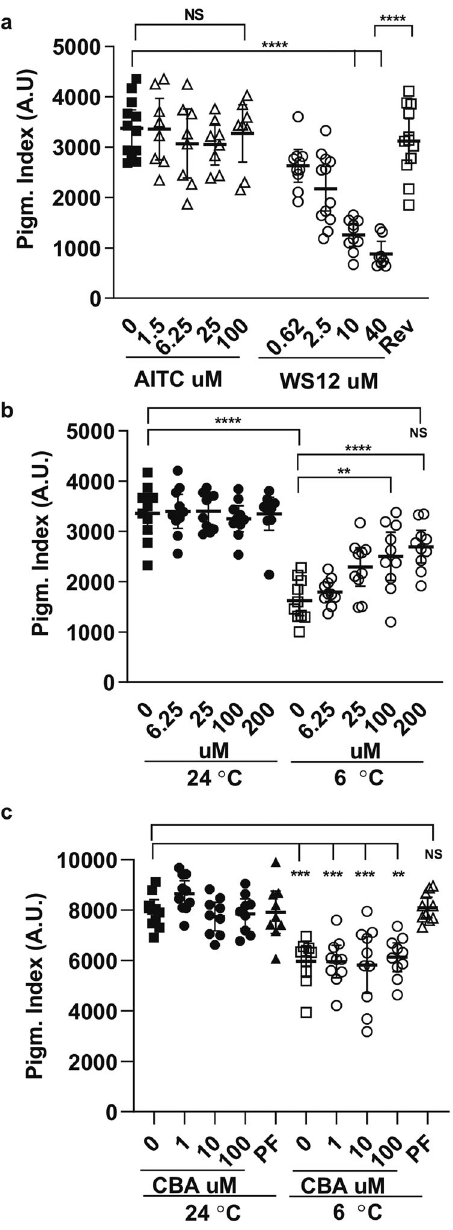
Fig. 4 Melanosome aggregation response to Trp channel agonists and antagonists. a Pigmentation index for stage 42/43 Xenopus tadpoles treated at 24 °C for 30 min at the indicated concentrations of TRPA1 (AITC) and TRPM8 (menthol; WS12) agonists. Reversibility (Rev) 6 h after removing the WS12. b , c A TRPM8 antagonist (PF05105679) blocks melanosome aggregation induced by cool temperature (6 °C) ( b ), while the TRPM4 blocker CBA has no effect ( c ); Each dot represented the measurement in one tadpole, and the bar is the mean with 95% con fi dence interval. n = 9 embryos; N = 3 independent experiments; ** p <